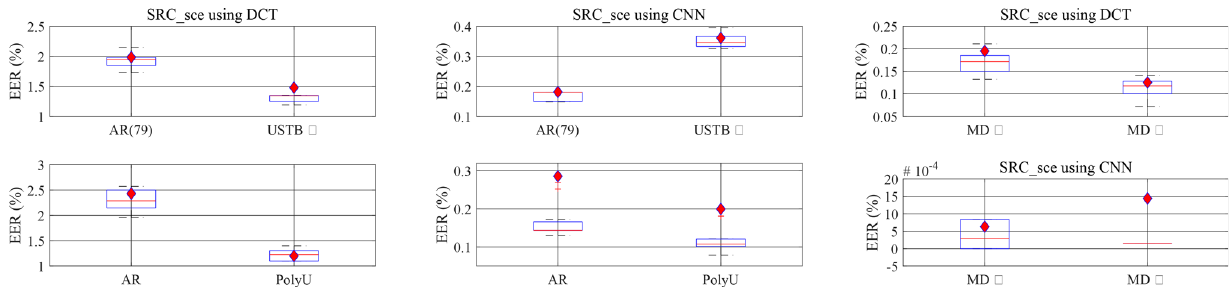
Fig. 14 The EER distributions of the SRC_sce with small random dictionaries on MD II and MD III. The red diamond marker denotes the EER obtained by the SRC_sce using a full dictionary